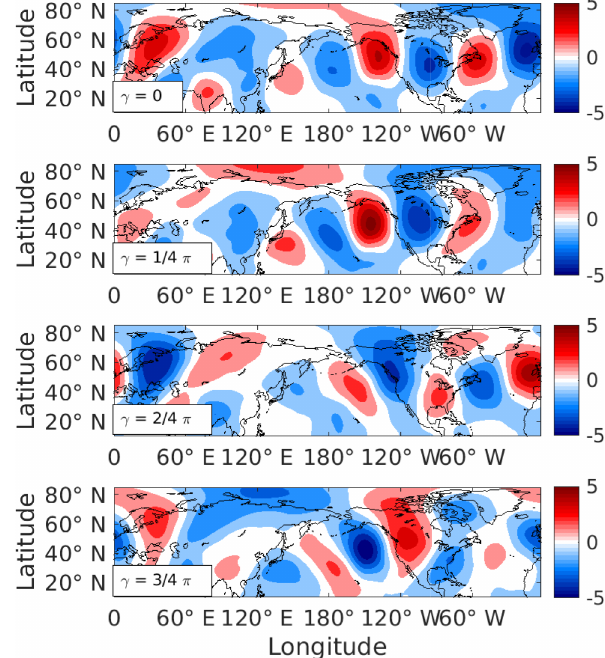
Figure 1. A simplified example of the relation between EOF phase angle and longitudinal phase. Each plot consists of a combination of the first two leading observational EOFs (represented by the γ value in Eq. 1). Red (blue) shading denotes positive (negative) V